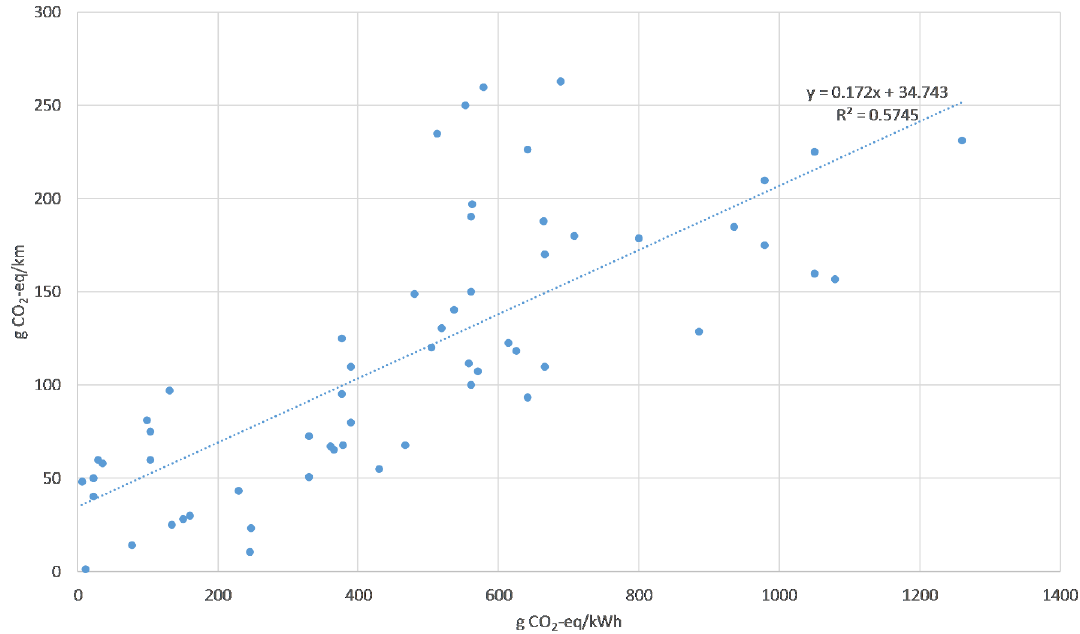
Figure 9. Linear regression between EVs climate change and carbon intensity of the electricity mix used to recharge them.